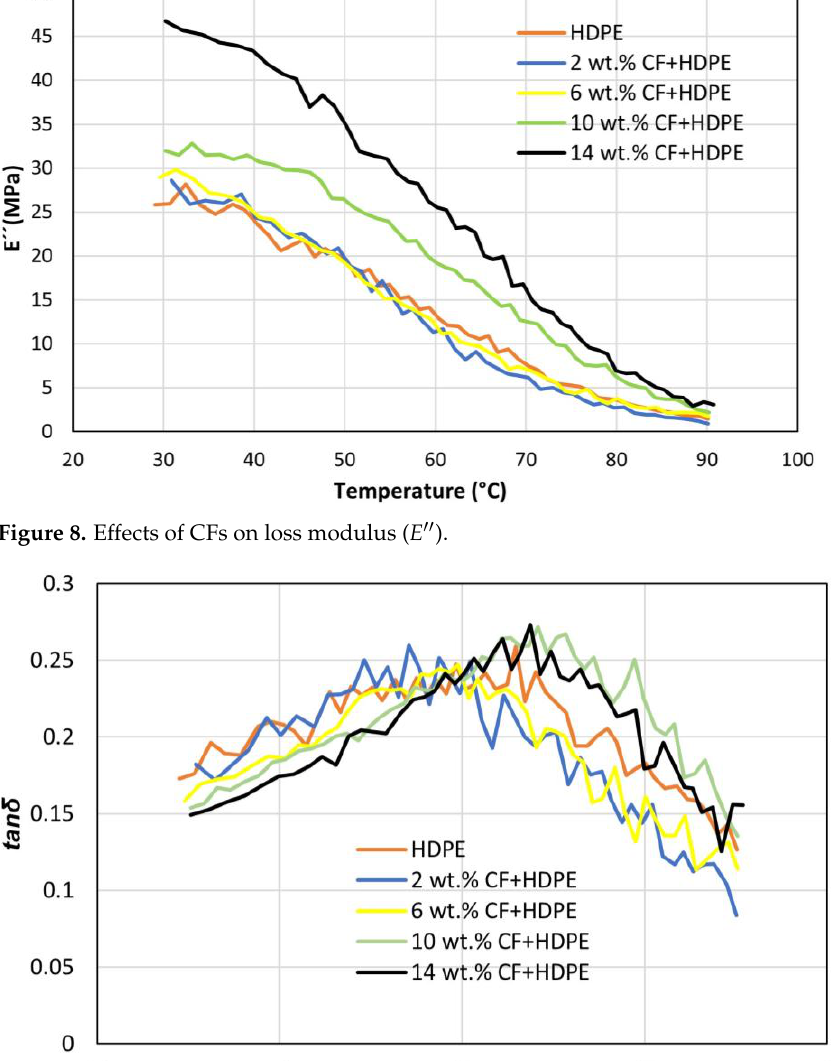
Table 4. A summary of dynamic mechanical properties.